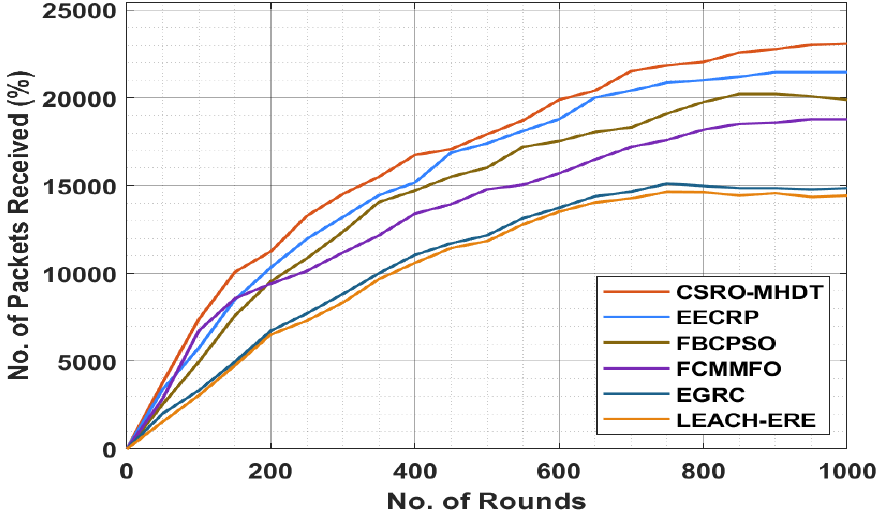
Figure 7. NPR analysis of the CSRO-MHDT technique in comparison with existing approaches. Table 7. PDR analysis of the CSRO-MHDT technique in comparison with existing approaches. Packet Delivery Ratio